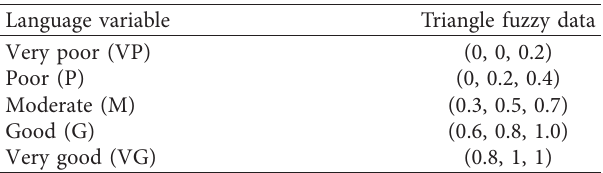
Table 1: Correspondence between Language variables and Triangle fuzzy